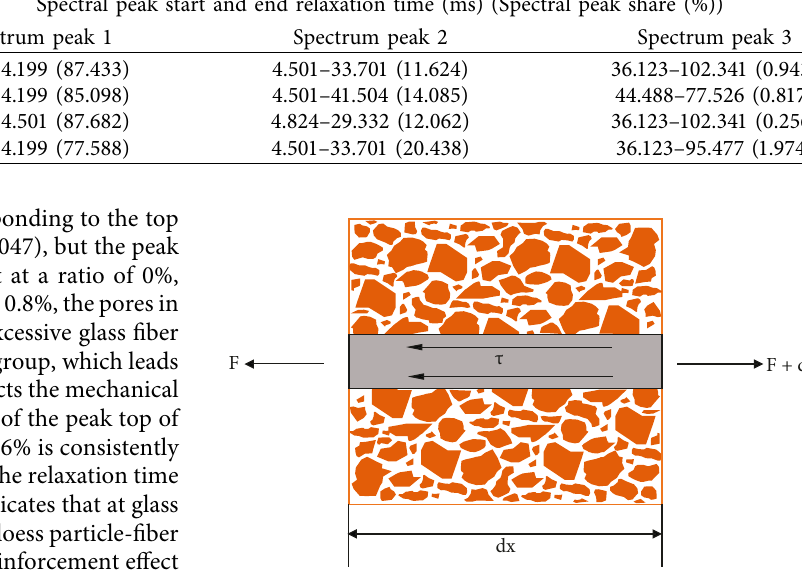
Table 4: Distribution of peaks in the T